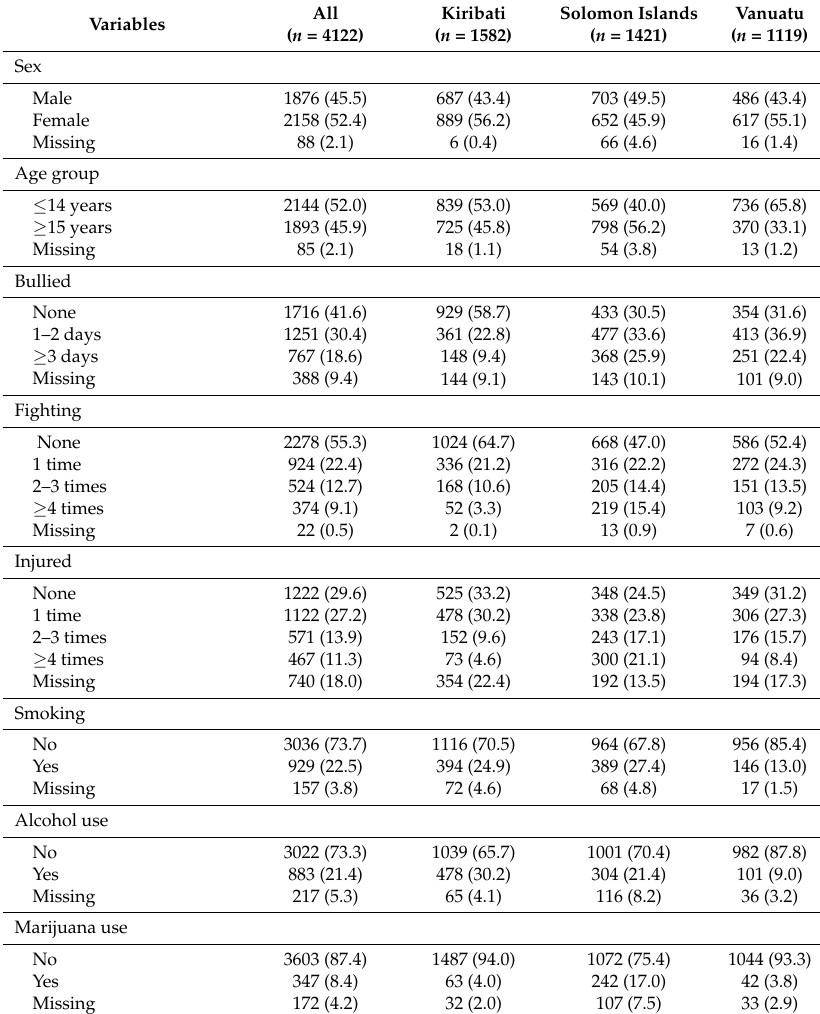
Table 2. Characteristics of the study